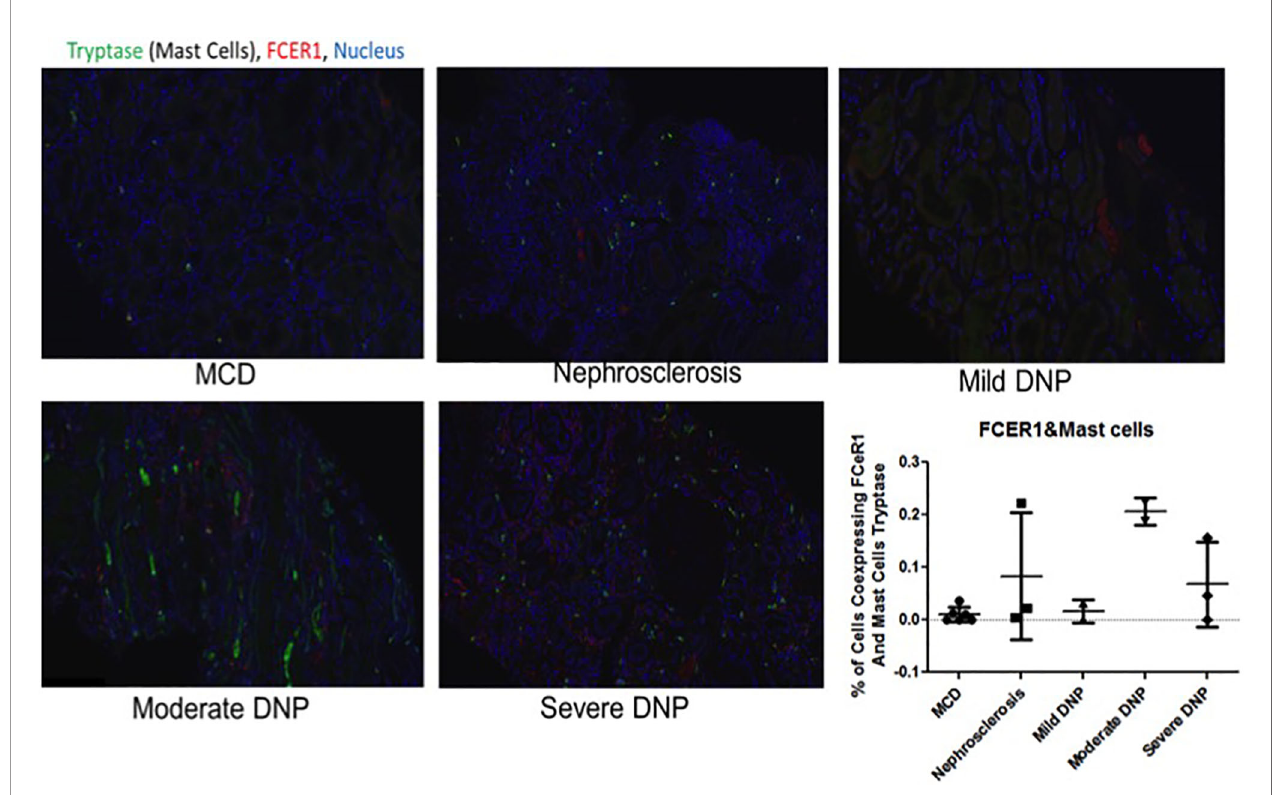
FIGURE 6 | Representative immuno fl uorescence staining for coexpression of FcER1 and in fl ammatory cell markers in human kidney tissue. Coexpression of FcER1 and mast cell marker. MCD, Minimal changed disease; DN, diabetic